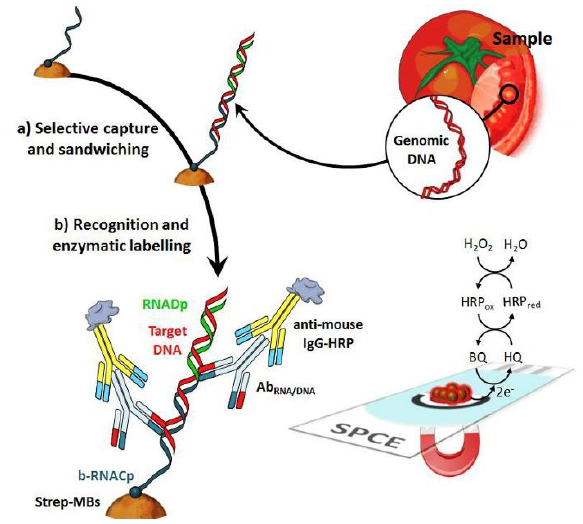
Figure 14. Scheme of the MBs-based amperometric biosensing strategy developed for detecting Sola l 7 allergen. Reprinted with permission from [152]. Copyright 2019, Elsevier. l 7 allergen. Reprinted with permission from [152]. Copyright 2019,